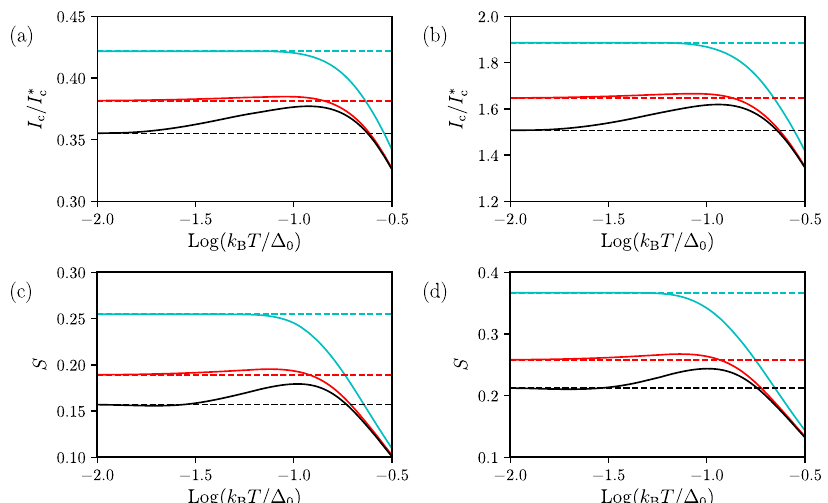
, and the Fermi energy is set at μ 0 = 0 and c = 0 and μ = 5 ħ v L , respectively. For both quantities, the 0 0 D /